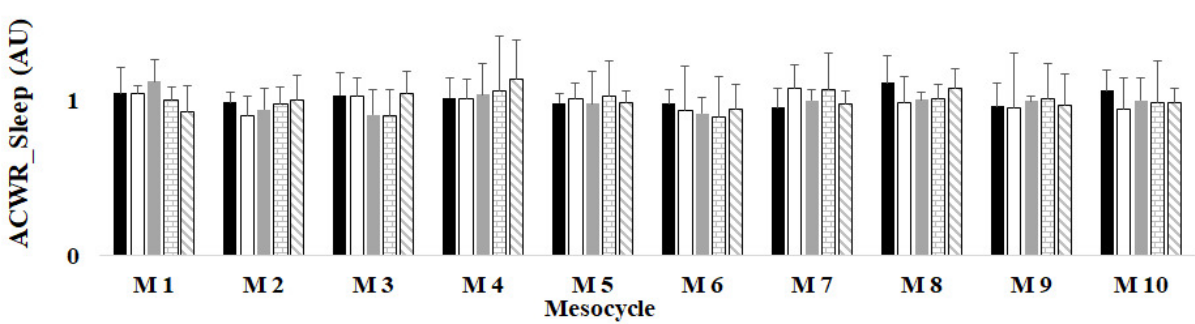
Fig. 6. Training Monotony (TM), Training Strain (TS) and Acute: Chronic Workload Ratio (ACWR) variations calculated through sleep quality category across 10 mesocycles (M1-10) for player positions. (A) TM. (B) TS. (C) ACWR. (b) denote significant difference from ST ( p < 0.05). CD, central defenders; WD, wide defenders; CM, central midfielders; WM, wide midfielders; ST,